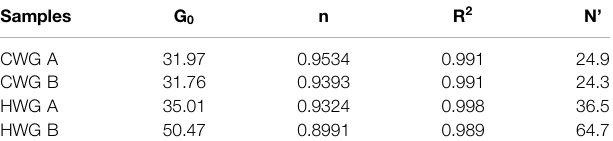
TABLE 5 | Summary of the G max fi tting